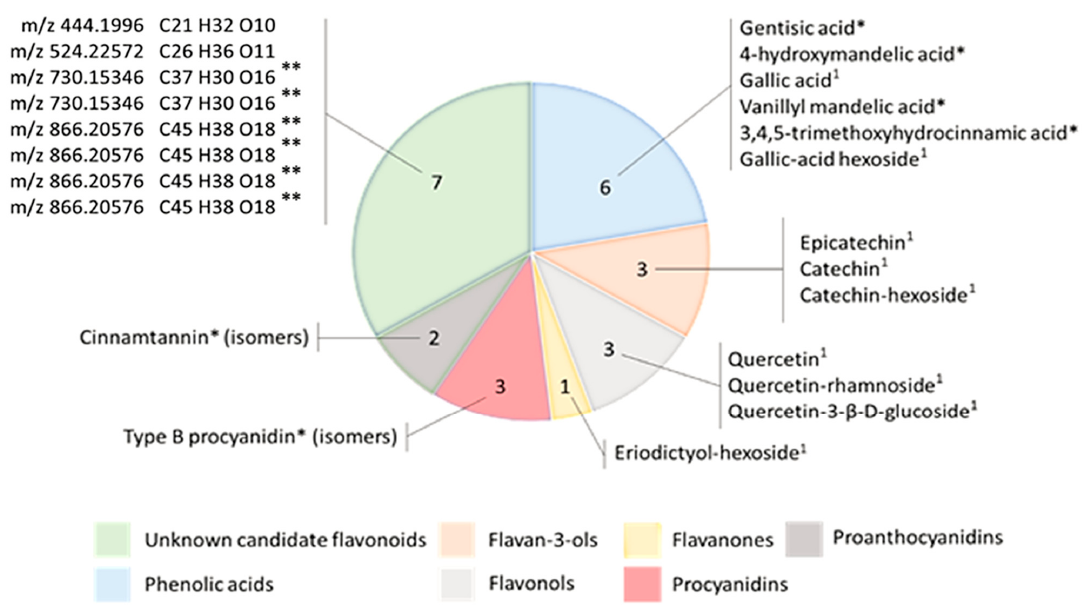
Figure 4. Coverage of the flavonoid contents in the model grape seed powder. Flavonoids 1 detected in targeted HCD30 MS 2 analysis. Flavonoids * detected with multiple matches with online and local databases. Flavonoids ** showing several isomeric forms detected at di ff erent retention times.